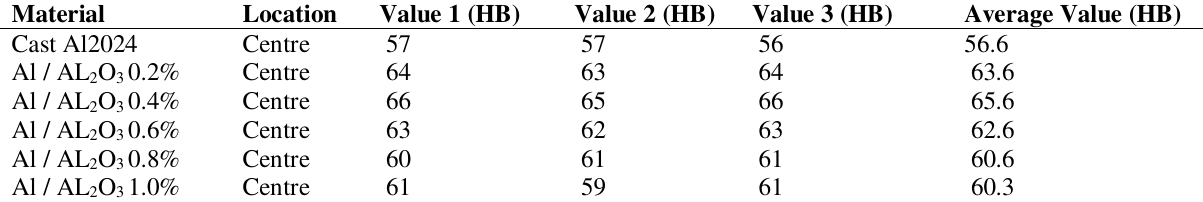
Brinell hardness Tests (HB)